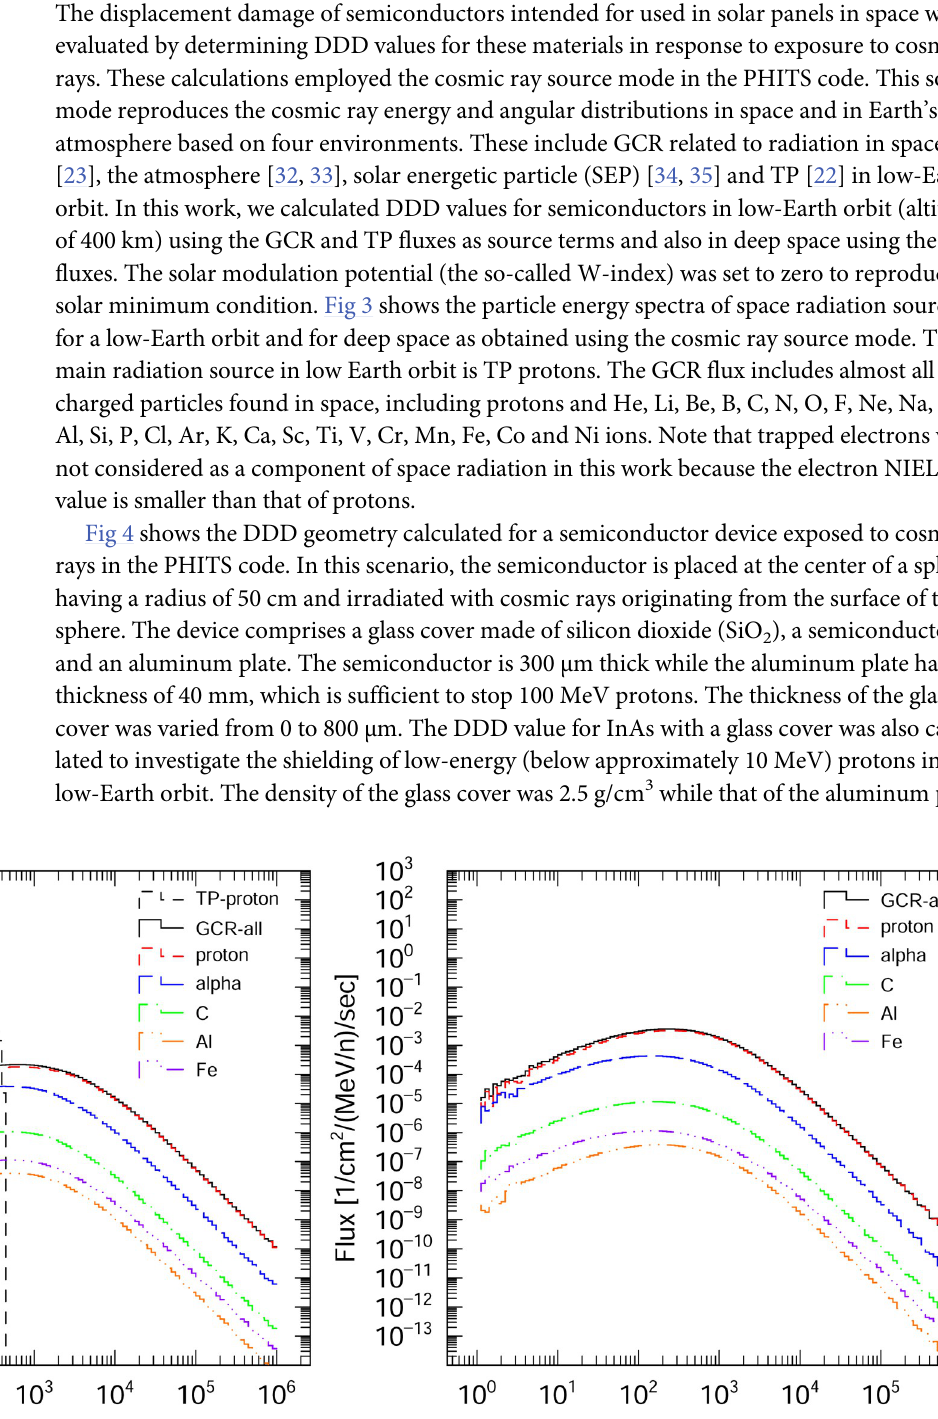
PLOS ONE | https://doi.org/10.1371/journal.pone.0276364 November3,